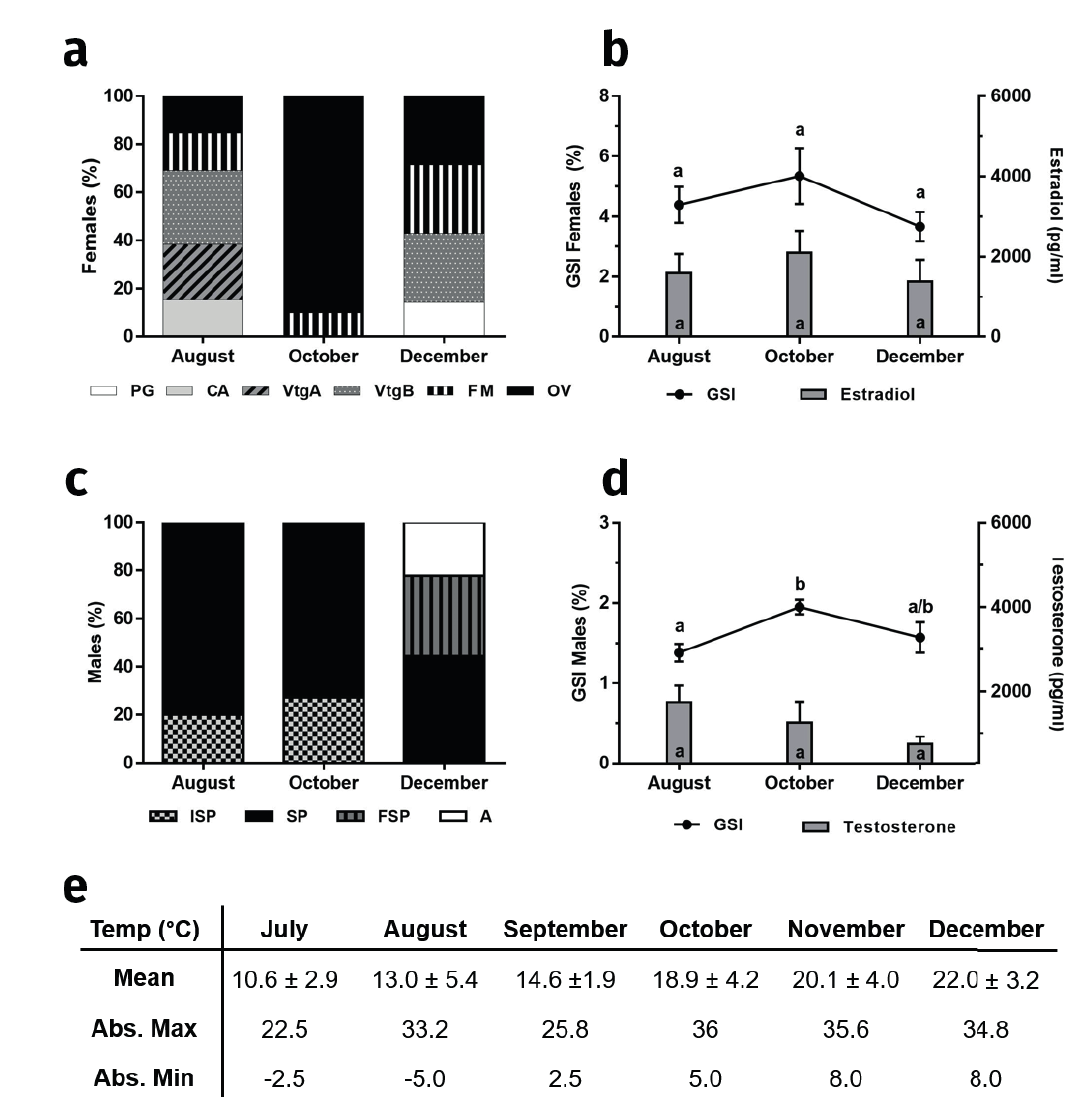
Figure 3. Pejerrey ( O. bonariensis ) sampling in Gómez lake (2014). a) Percentage of females at different gonadal stages. CA: cortical alveoli stage; VtgA: initial vitellogenesis stage; VtgB: advanced vitellogenesis stage; FM: fi nal maturation stage; OV: ovulated females; AT: atretic stage. b) Female gonadosomatic indexes (GSI: dots) and E plasma levels (bars). Values are mean ± SEM. Different letters represent signifi cant differences between sampling dates (Tukey’s multiple comparison test. p < 0.05). c) Percentage of males at different gonadal stages. ISP: Initial spermiogenic; SP: spermiogenic; FSP: fi nal spermiogenic; A: arrested. d) Male gonadosomatic indexes (GSI: dots) and T plasma levels (bars). Values are mean ± SEM. Different letters represent signifi cant differences between sampling dates (Tukey’s multiple comparison test. p < 0.05). e) Air temperature (°C) during the spawning season. Mean: Monthly mean temperature; Abs. Min.: Absolute Minimum; Abs. Max.: Absolute